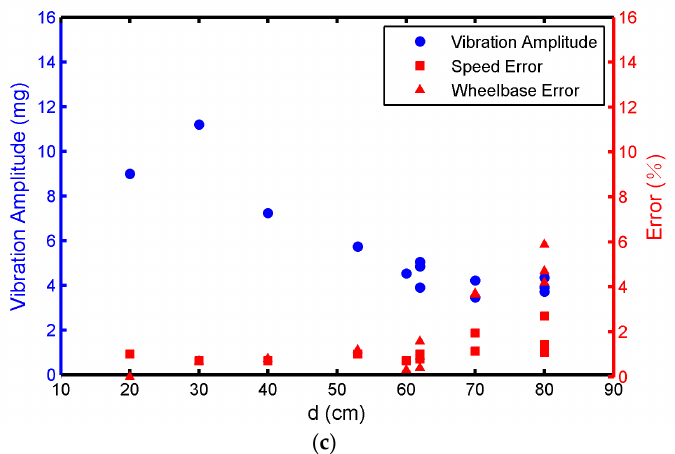
Figure 12. The effects of d on the vibration amplitude, speed error, and wheelbase error. ( a ) Buick GL-8; ( b ) Ford Transit; ( c ) Toyota Coaster.